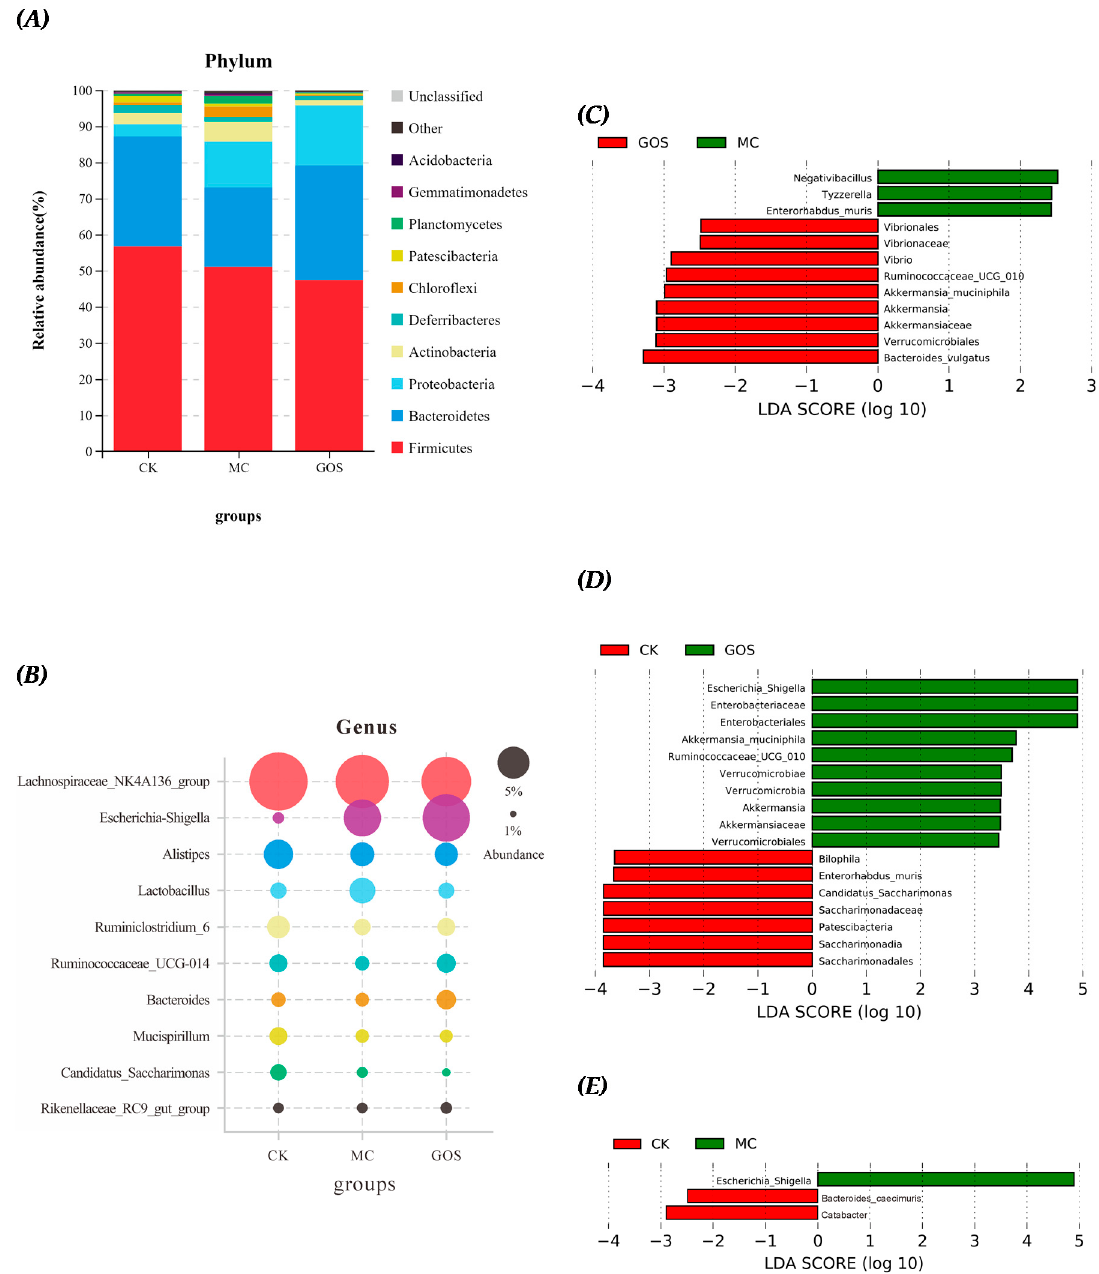
Figure 7. Relative abundance and Linear Discriminant Analysis (LDA) of intestinal flora in di ff erent groups of mice. ( A ) Relative abundance of phylum level; ( B ) Relative abundance of genus level; ( C ) LDA in MC group and galactooligosaccharide (GOS) group; ( D ) LDA in blank control (CK) group and GOS group; ( E ) LDA in model control (MC) group and CK group.